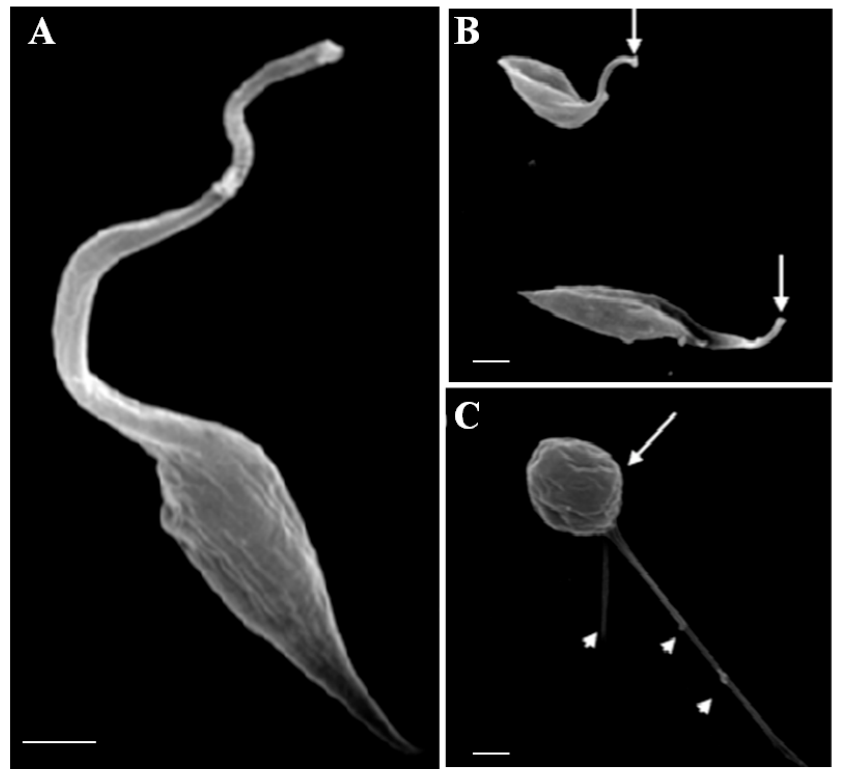
Figure 7. Scanning electron micrographs of T. cruzi epimastigotes treated with compound 27 . ( A ) Control after 72 h of growth. Integrity of untreated cells: elongated cell body and single tapering flagellum; ( B ) shortening of the flagellum when compared to the control (arrow); ( C ) multiple flagella (arrowheads) and misshapen cell body (arrow). Bars = 1 μ M.